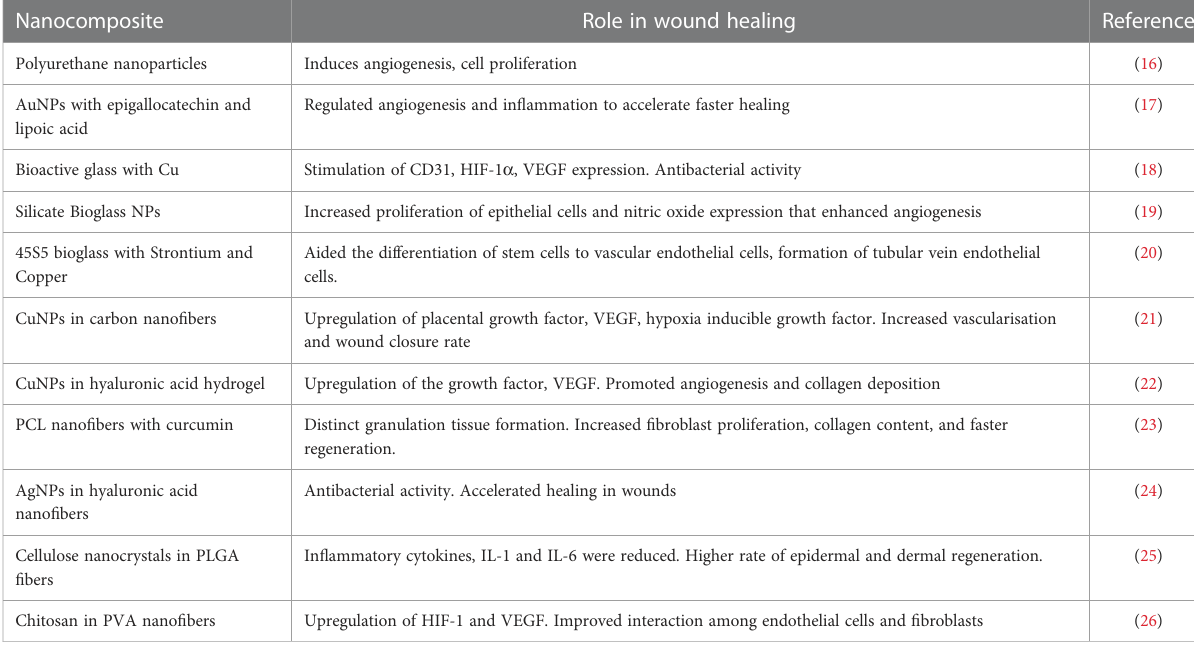
TABLE 1 Types of nanocomposites employed for diabetic wound healing. Nanocomposite